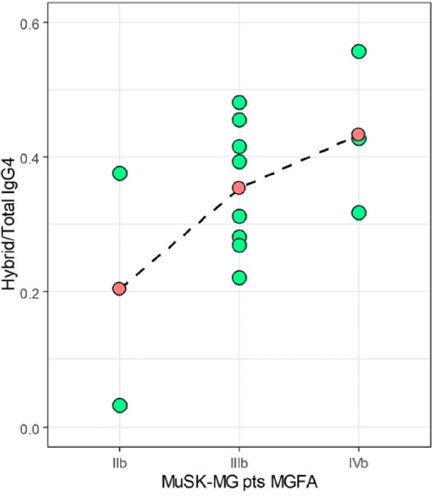
Figure 4. Distribution of Hybrid/Total IgG4 ratios (green-filled dots) at different MGFA scores for MuSK-MG pts (only samples of pts #1-13 were analyzed). Mean values are represented as red-filled dots joined by a dashed line.